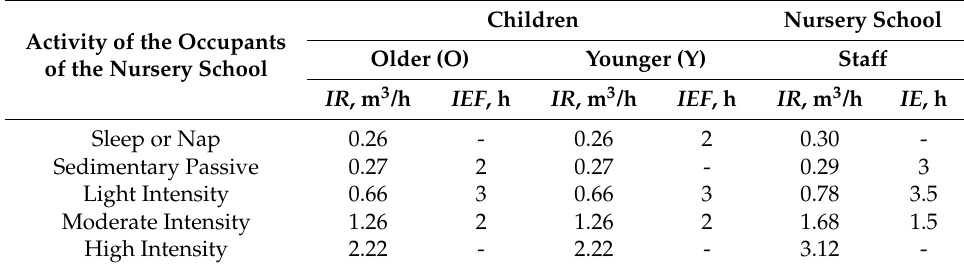
Table 3. Dependence of the Inhalation Rate (IR) and Indoor Exposure Fraction (IEF) on children and staff’s physical activity levels.